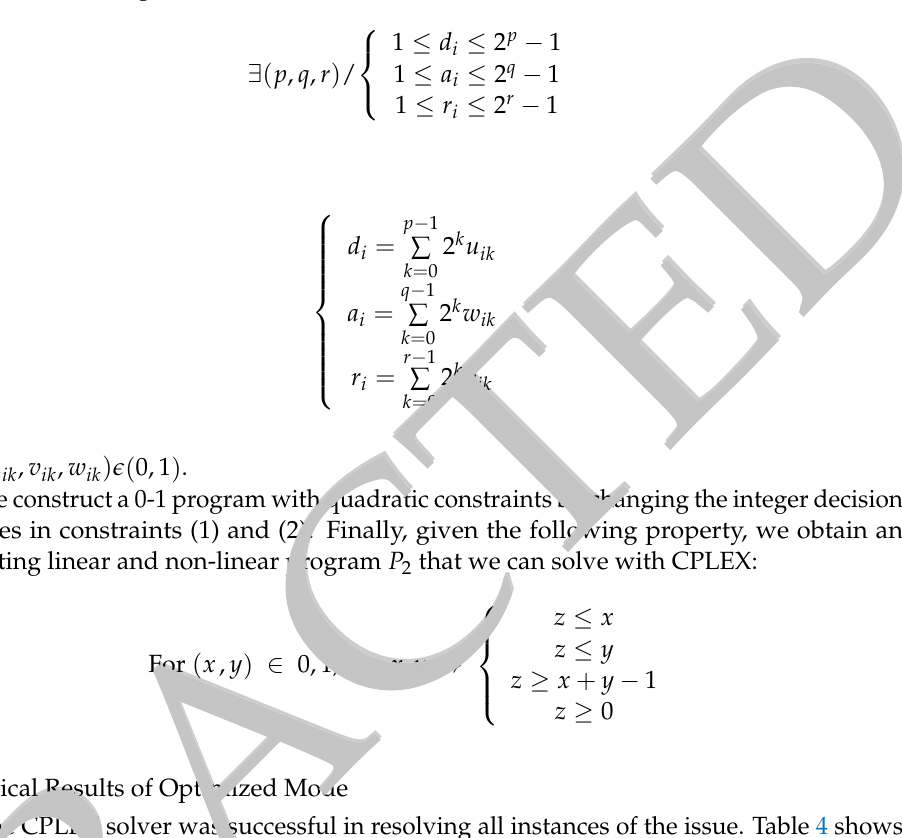
Table 4. Results of the optimization